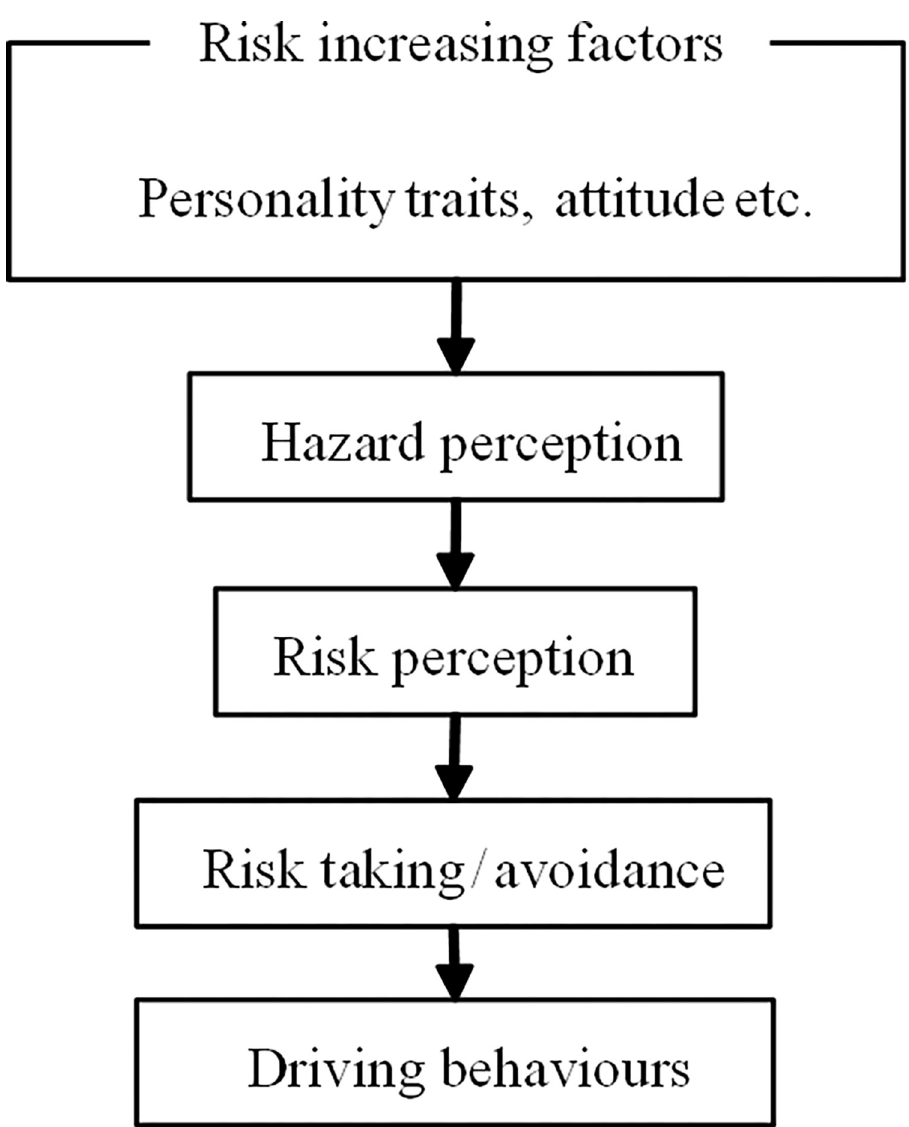
Fig 1. Driving behaviour model based on risk perception